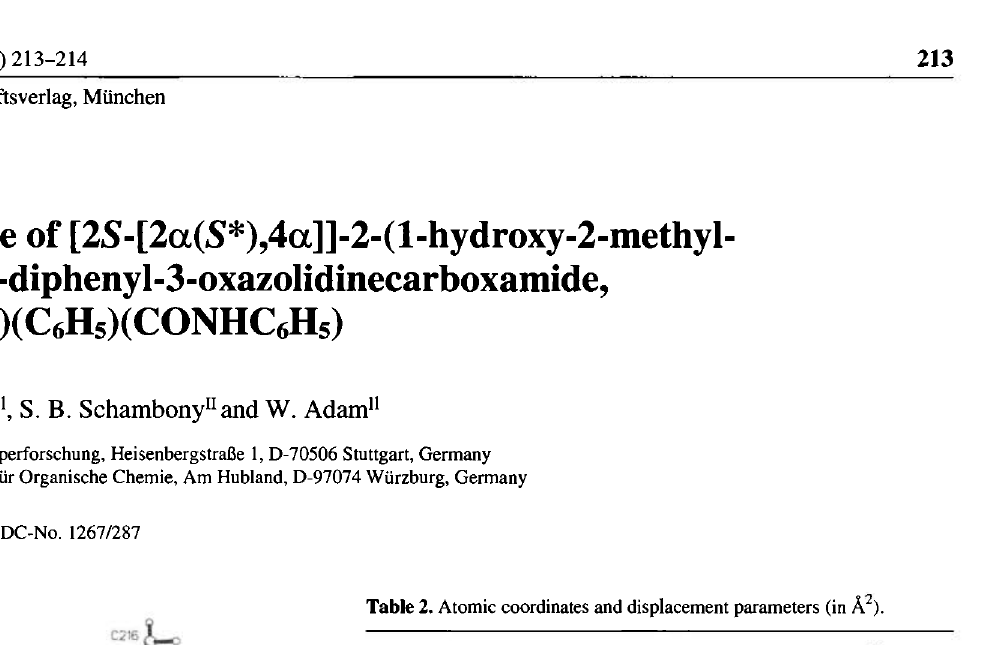
Table 2. Atomic coordinates and displacement parameters (in Ä 2 ).